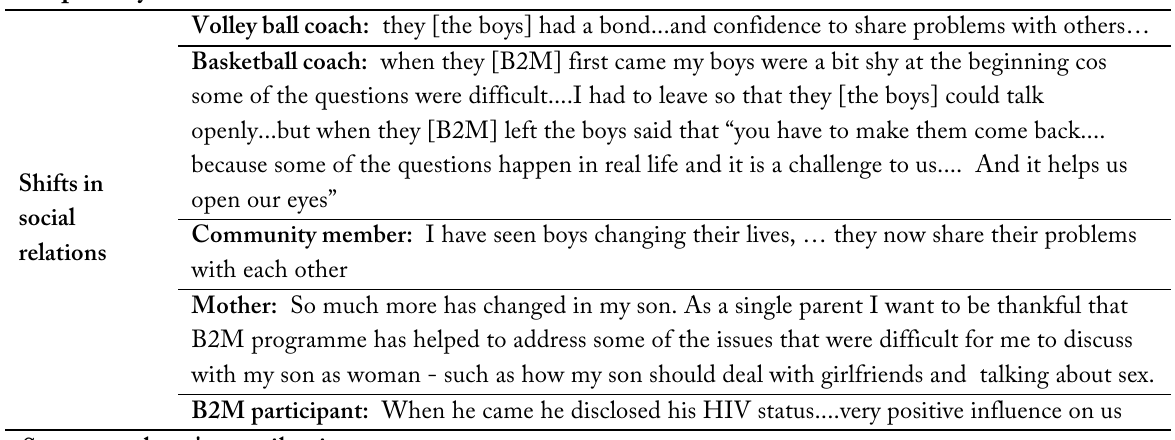
Table iv: Shift in social relations surface some of the properties and dynamics of the complex adaptive